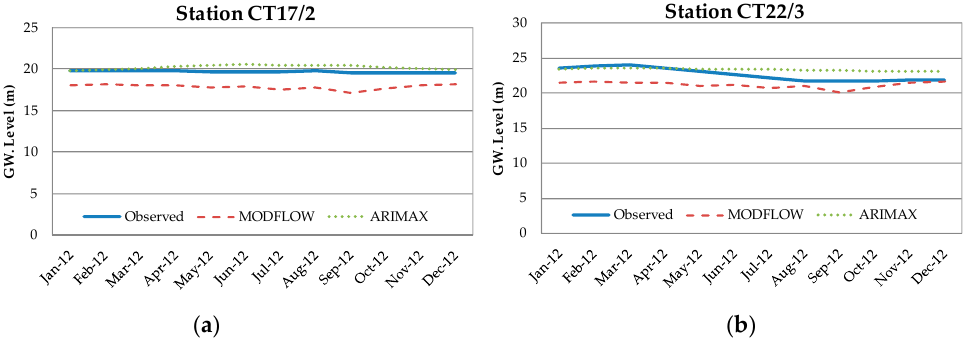
Figure 15. Comparison of forecast groundwater levels between ARIMAX and MODFLOW, examples for ( a ) CT17/2 and ( b ) CT22/3 stations.